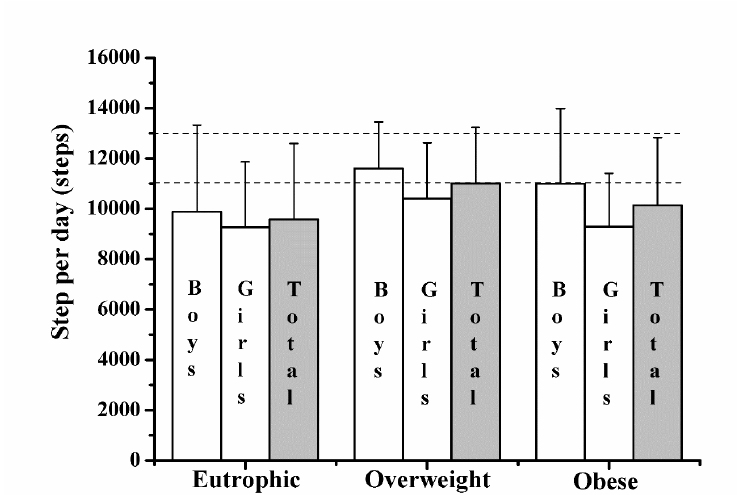
Figure 1. Number of steps per day. Data expressed as mean ± standard deviation. Eutrophic (n=19 boys and 17 girls). Overweight (n=18 boys and